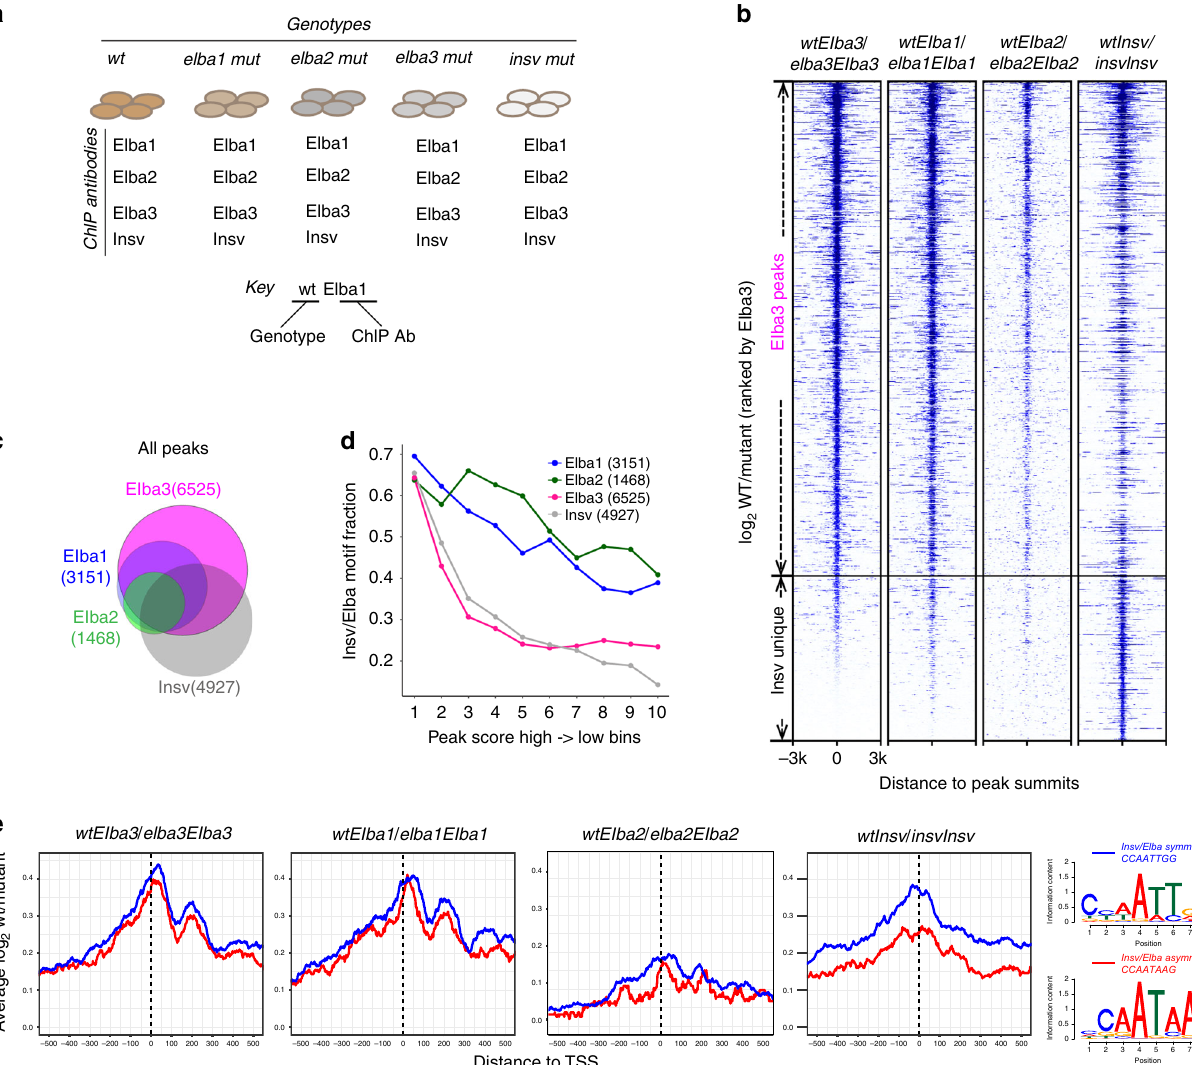
Fig. 1 Comparison of the ELBA complex with Insv-binding sites and motifs. a Illustration of the ChIP-seq samples. The naming scheme: the gene names with all the letters in lower case denote genotypes, and the names with the fi rst letter in upper case denote antibodies in ChIP. Two examples are shown. b For each factor, the peaks were called by using the ChIP-seq reads of wt against the ChIP reads of its cognate mutant. A heatmap of the ChIP-seq coverage ratio (log2 wt/mutant) centered at peak summits, ranked by the Elba3 signal, showing the peaks of Elba1, Elba2, and Elba3 largely overlap, while Insv has unique peaks. c A Venn diagram shows peak overlapping of the four factors. d The peak scores and the Elba/Insv motif enrichment are positively correlated. The peak scores were ranked and divided into ten bins ( x -axis), and the fraction of motif-containing peaks was calculated for each bin. e The coverage ratio (log2 wt/mutant) centered at TSS is shown for the peaks that contain either the symmetric or asymmetric motif. The Elba factors show similar preference at both types of motifs, while Insv signal is higher at the symmetric motif. Logos of the Insv/ELBA motifs from de novo motif discovery are shown on the